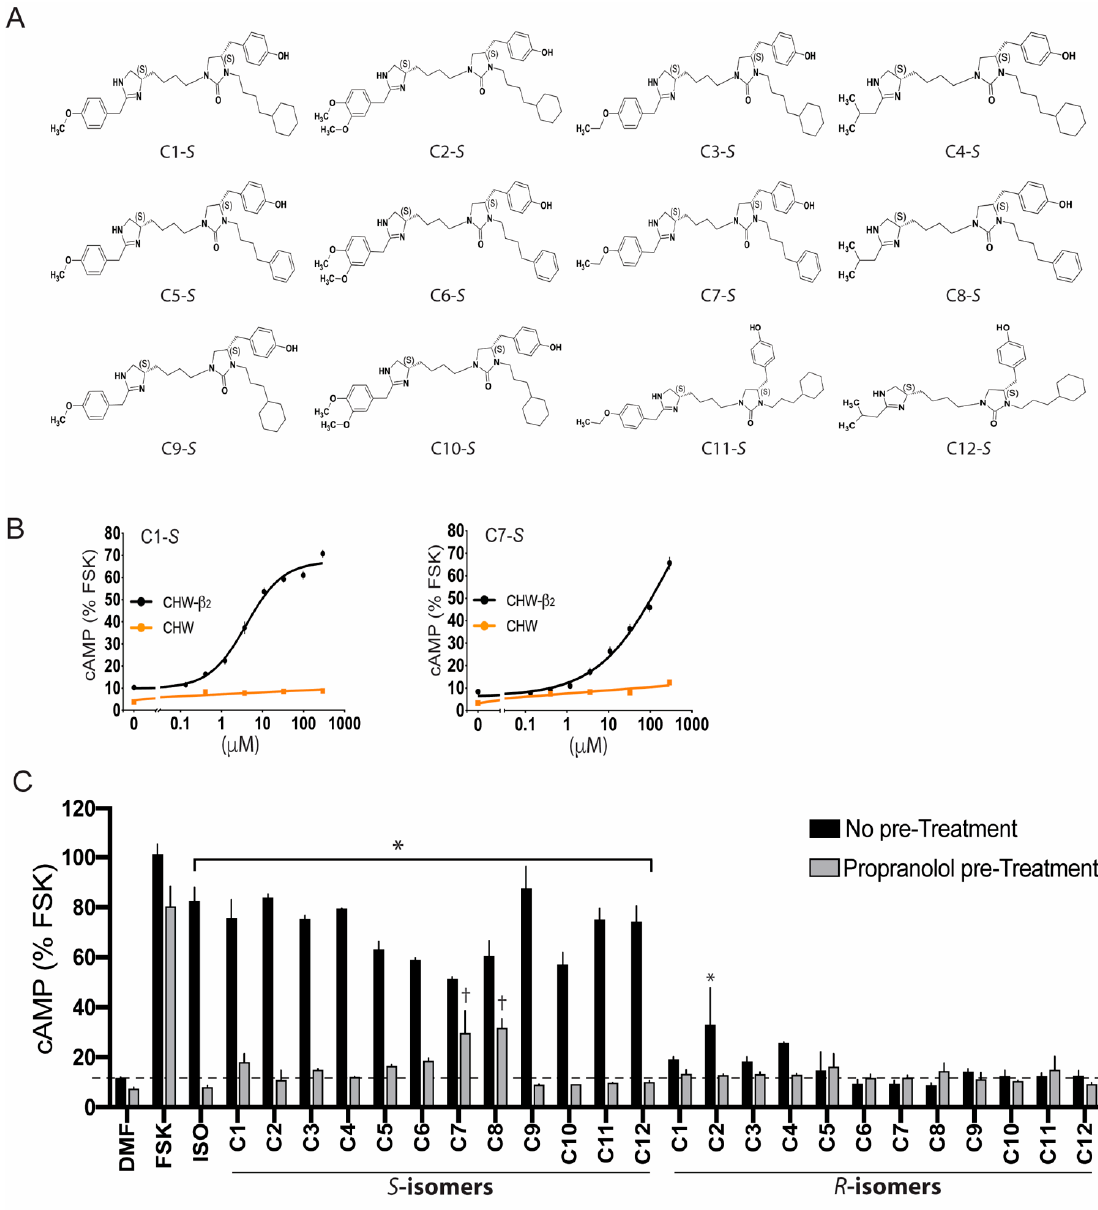
Figure 3. Evaluation of individual compounds derived from the discovery scaffold. ( A ) Computational methods indicated 12 specific combinations of R 2 and R 3 with the R 1 group = S -4-hydroxybenzyl as potentially being active agonists. These structures are shown and are denoted C1-S through C12-S. The R-stereoisomers at position R 1 denoting C1-R through C12-R are not shown. ( B ) Selected dose–response curves in the indicated cells of two compounds, illustrating the screening process leading to further studies. C1-S responses were fit to a sigmoid curve (R 2 > 0.95) with a Hill slope of 1.06 and this compound was taken forward to the biasing studies. In contrast, C7-S responses did not reach a plateau and this compound was not taken forward. Note also that C1-7 responses were not fully blocked by the β 2 AR antagonist propranolol (Figure 3C). ( C ) cAMP responses to C1-S through C12-S and C1-R through C12-R in the absence and presence of the receptor antagonist propranolol. C7-S and C8-S failed due to the lack of complete blockade of signaling by propranolol, while C2-S failed because its stereoisomer C2-R in the absence of propranolol was partially active (see text for details). *, p < 0.01 and †, p < 0.05, response to a compound is greater than